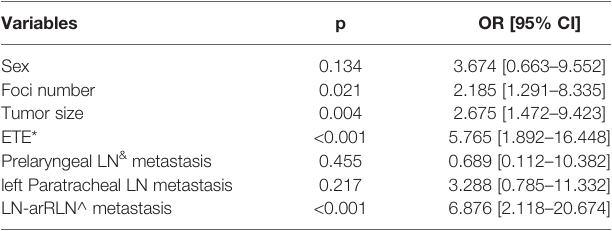
TABLE 3 | Multivariate analysis predictor for lymph node posterior to the right recurrent nerve metastasis. Variables